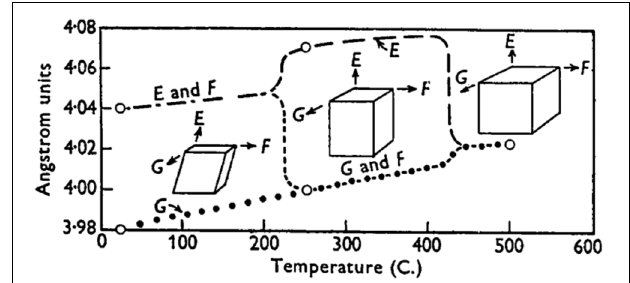
FIGURE 2 | Polymorphism in KN (Wood, 1951) (Reproduced with permission of the International Union of Crystallography